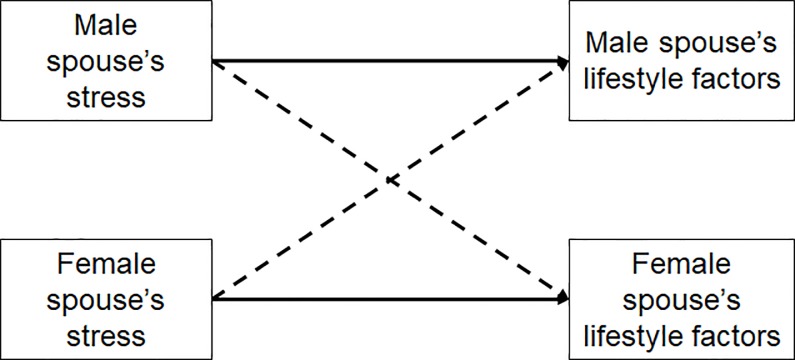
Conceptual framework of the actor-partner interdependence model of the present study.Solid lines reflect actor effects indicating that one spouse’s stress influences his/her own lifestyle factors. Broken lines reflect partner effects indicating that one spouse’s stress influences the other spouse’s lifestyle factors.